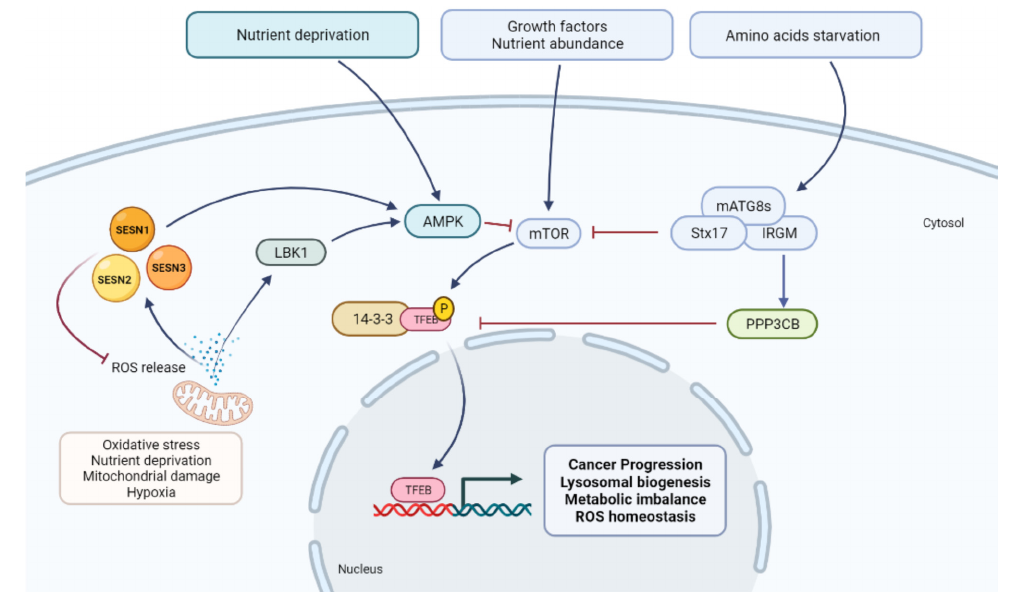
Figure 1. Main extracellular stimuli and intracellular pathways controlling TFEB activation. TFEB is the master tran- scriptional regulator of both autophagy and lysosomal components, responding to important biological pathways and cellular functions. TFEB translocation to the nucleus depends on its phosphorylation status. Various extracellular and intracellular stimuli including growth factor/nutrient abundance or deprivation and oxidative stress activate, among others, LBK1/AMPK and/or mTOR signaling which control TFEB phosphorylation status. Once phosphorylated, TFEB is sequestered in the cytosol by 14-3-3 proteins. Conversely, during starvation TFEB is dephosphorylated by PPP3CB enabling its nuclear translocation.